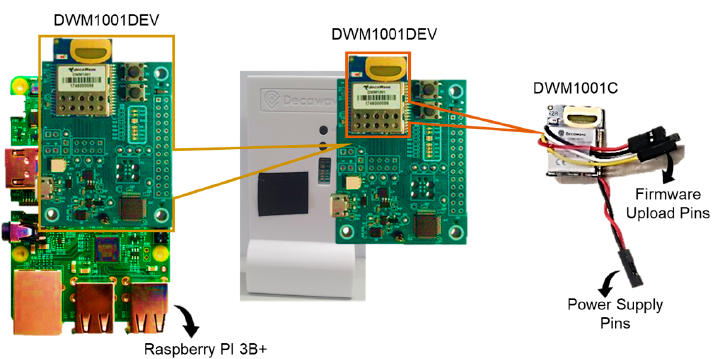
Figure 2. Characterization of UWB sensors (left side = bridge; center = anchor; right side = customized tag).